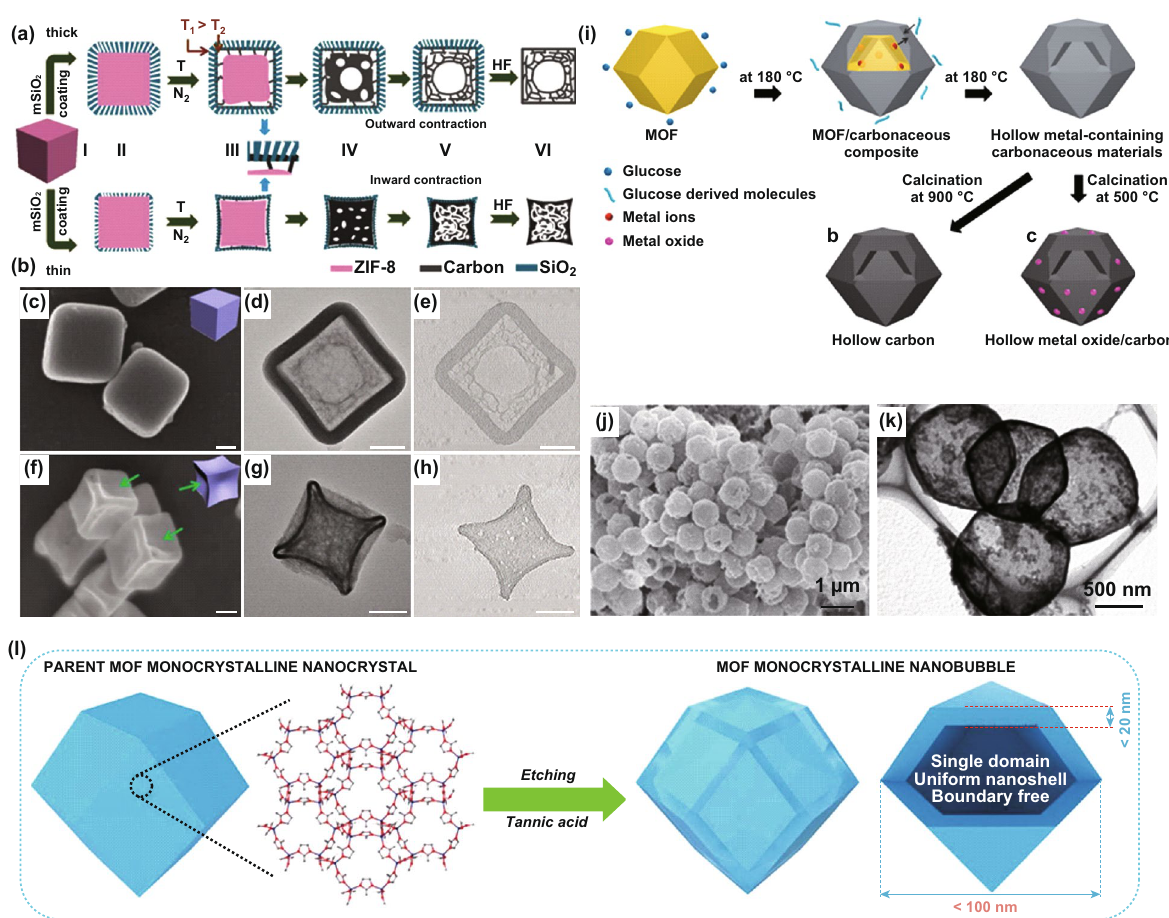
Fig. 6 Schematic illustration of the fabrication processes of a HMCNCs and b SMCNCs. c , f SEM images, d , g TEM images, and e , h electron tomography slices of carbon@mSiO 2 -40 and carbon@mSiO 2 -8, respectively, scale bar: 100 nm. Reproduced with permission from Ref. [96]. Copyright 2018, Wiley–VCH. i Schematic illustration of the preparation of hollow carbonaceous materials. j SEM, and k TEM images of the HZC-2.5 M-2 h. Reproduced with permission from Ref. [100]. Copyright 2018, American Chemical Society. l Schematic illustration of the spatially controlled etching to produce monocrystalline ZIF nanobubbles. Reproduced with permission from Ref. [101]. Copyright 2017, Royal Society of